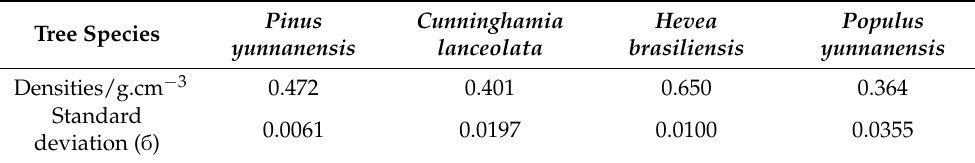
Pinus yunnanensis